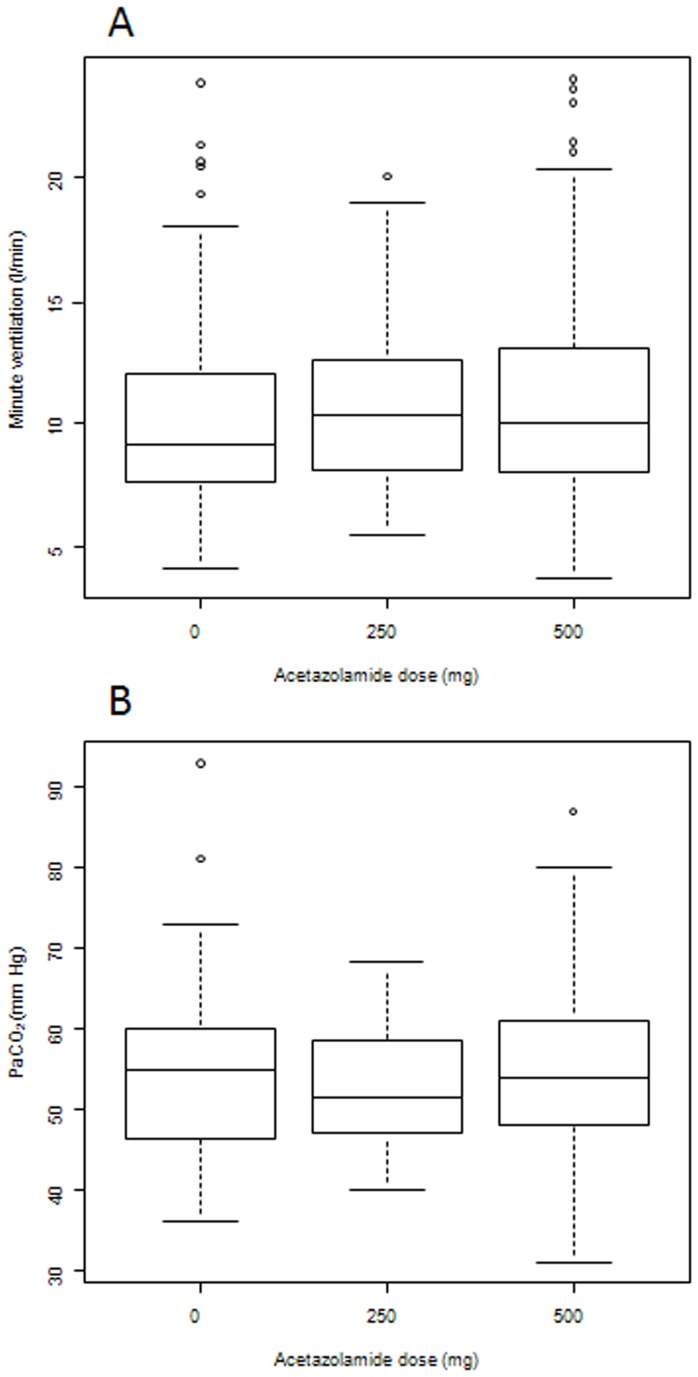
Difference between respiratory parameters pre-acetazolamide dose and at 24 hours.Differences between pre-acetazolamide dose minute ventilation and minute ventilation at 24 hours (A) and between pre-acetazolamide dose PaCO2 level and PaCO2 level at 24 hours (B) in 68 COPD patients, plotted according to the total quantity of acetazolamide administered daily. Boxplots show the median values, first and third quartiles and 10th and 90th percentiles. All values are observed. Usually administered doses of acetazolamide (250–500 mg) do not have a clinically relevant effect either on minute ventilation or on PaCO2 levels.